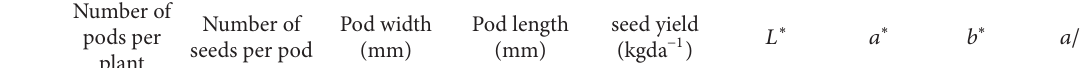
Table 3: Pearson’s correlation coefficient used to assess correlation among the seed coat colour and seed yield parameters of 70 common vetch lines and cultivars and related 𝑝